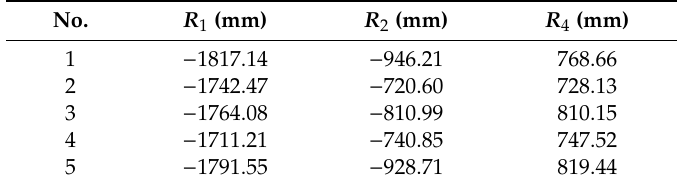
Table 4. Configuration parameters of the initial o ff -axis four-mirror system.